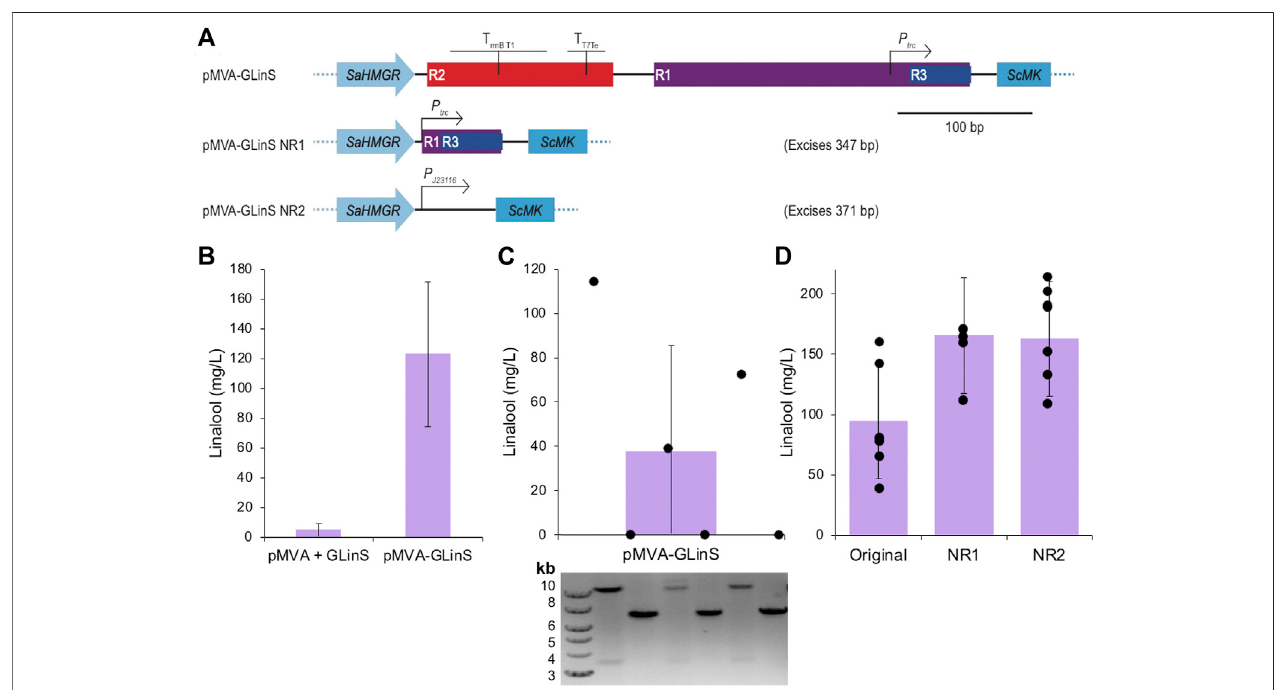
FIGURE 2 | Linalool production by recombinant plasmid-based E. coli DH5 α . (A) Schematic of the method of elimination of repeating regions R1, R2, and R3 of pMVA-GLinS and incorporation of the constitutive promoter P J23116 to control the expression of the MevB lower MVA pathway enzymes. (B – C) Linalool production of biological replicates of E. coli DH5 α containing the one or two plasmid system. Cultures (3 ml) were incubated in TB medium containing 0.4% glucose and antibiotic selection at 37 ° C until growth was visible, followed by induction with 50 µM IPTG. A further incubation at 30 ° C was performed for 68 – 72 h and linalool production was determined by GCMS analysis. Part C also contains a diagnostic agarose gel electrophoresis of the plasmid fragmentation pattern of the biological replicates suggestiveofpotentialrecombinationevents.Theplasmiddiagnosticgellanesarealignedverticallywiththelinalooldatapoints(blackcircles),whichareindividuallinalool assays of single colonies of E. coli DH5 α containing pMVA-GLinS. Possible recombination events are detailed in Supplementary Figure S2 . (D) Variation in biological replicatesinlinaloolassaysby E.coli DH5 α containingtheoriginalpMVA-GLinSandvariantsNR1-NR2.Errorbarsrepresentonestandarddeviationofthedata.Individual biological replicates are shown as black